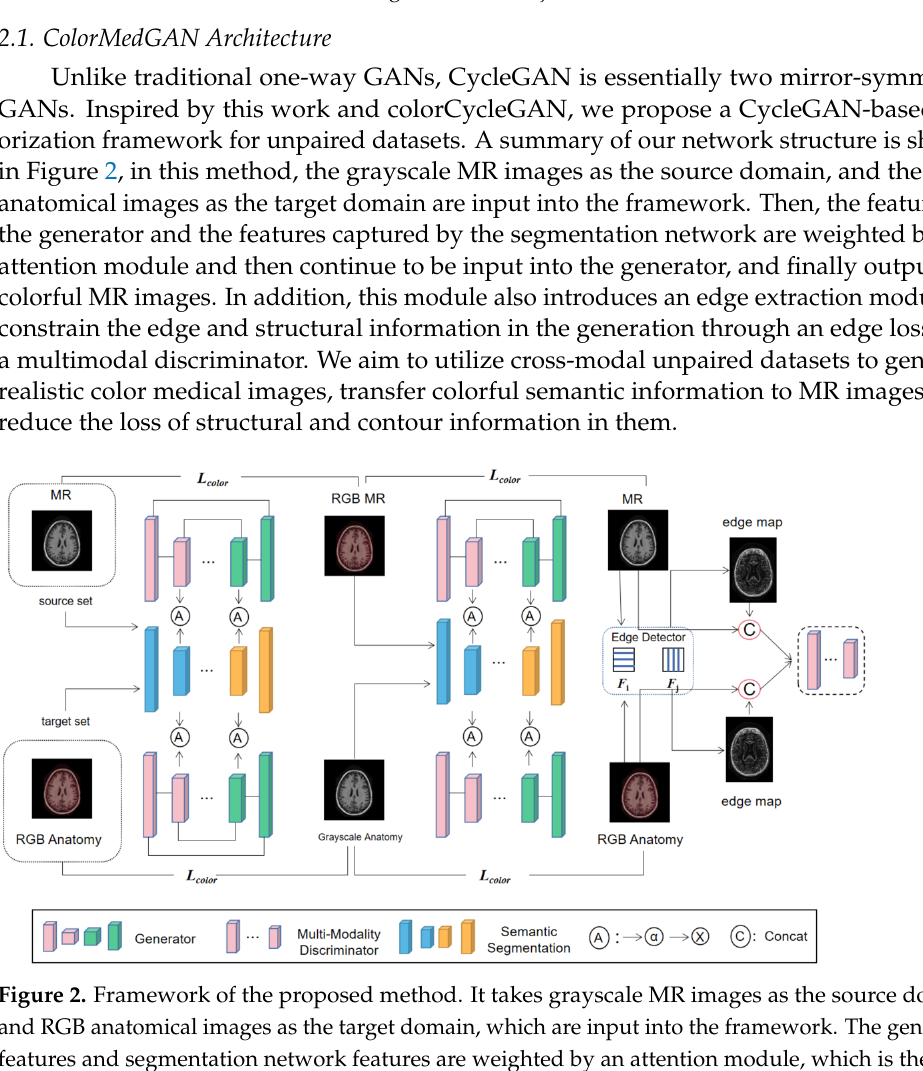
Figure 1. ( a ) illustrates the MR-to-anatomical synthesis cycle in color space. ( b , c ) primarily demon- strate the forward synthesis from MR to anatomical and the backward synthesis from anatomical to anatomical, with the inclusion of the edge and color object functions.